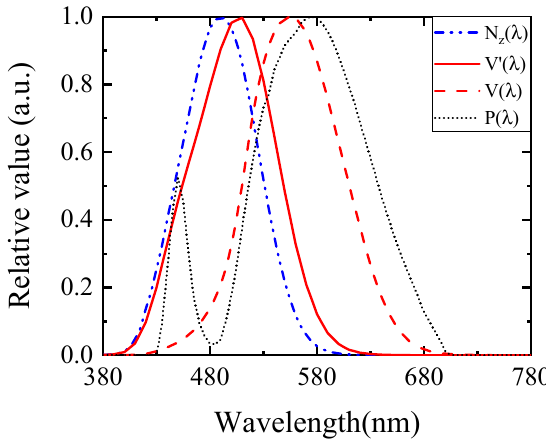
Figure 14. Spectral power distribution P( λ ) of the LED luminaires used in the three roads. The V ′ ( λ ) and V( λ ) are the scotopic and photopic sensitivity functions. The N z ( λ ) is the melanopic sensitivity function [31]. Characteristics of the LED luminaires are correlated color temperature 3640 K, chromaticity coordinates (0.42, 0.45), CIE R a 63, and IES R f 69 and R g 85.